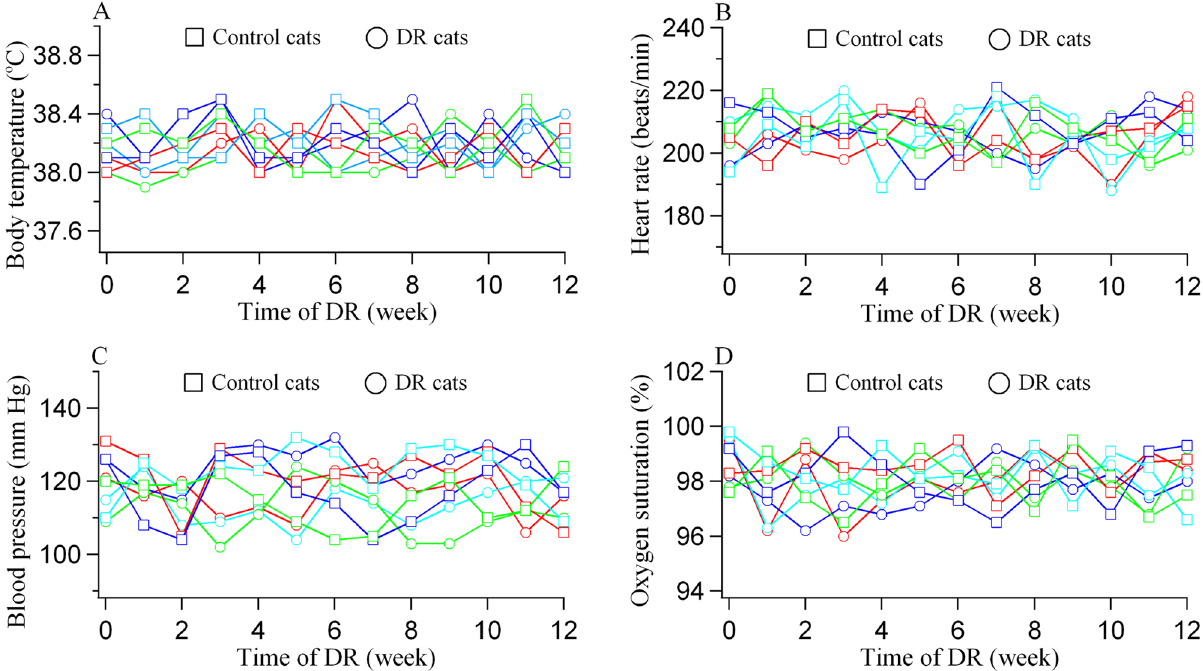
Fig 3. Record of body temperature (A), heart rate (B), femoral artery contraction blood pressure (C) and blood oxygen saturation (D) for each DR cat and control cat during the period of DR. Open squares represented normal control cats (NC1: red; NC2: blue; NC3: cyan; NC4: green). Open circles denoted DR cats (DR1: red; DR2: blue; DR3: cyan; DR4: green).